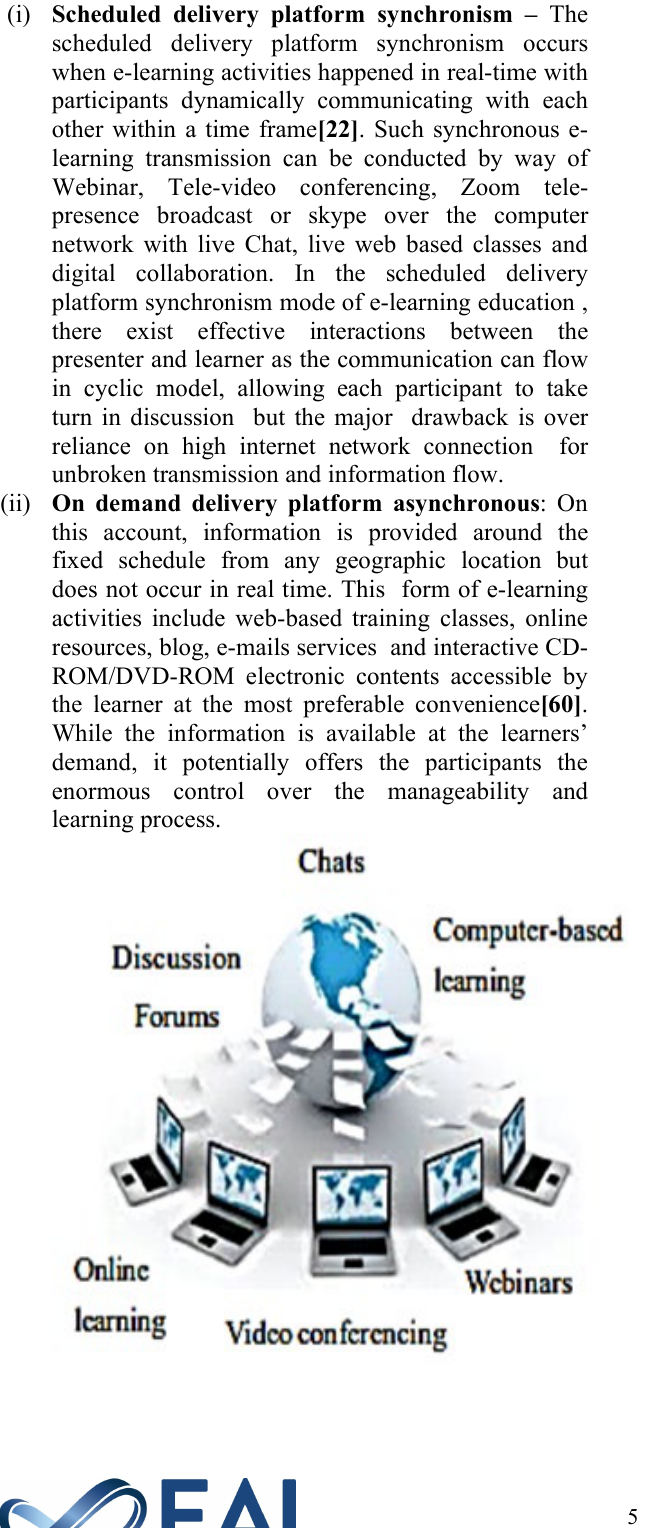
With Figure 2, the e-learning education depend on ICT infrastructures in delivering it’s key potentials in higher education and learning environment , while concentrating attention on information and knowledge sharing which is the sole objective of